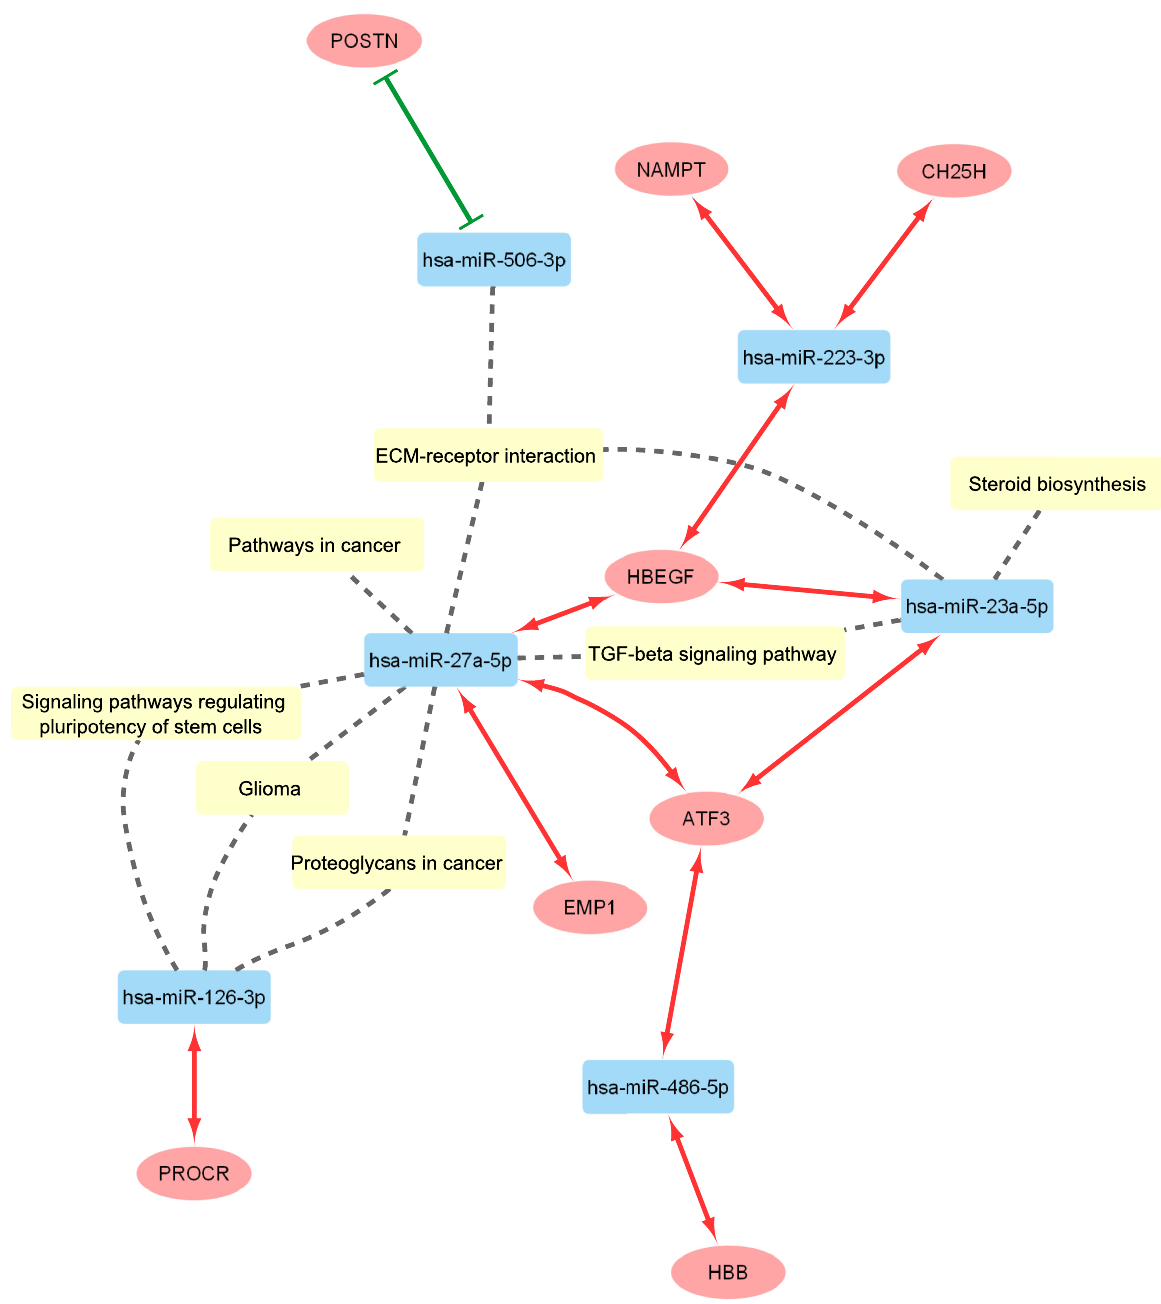
Fig 1. Network analysis of 12 miRNA-mRNA interaction pairs associated with OS in EOC patients. Each blue rectangular node represents a miRNA, whereas each red oval node presents a mRNA. Edge with solid green line indicates negative correlation between a miRNA and a mRNA (P < 0.05, R < -0.4), while red arrow line designates positive correlation (P < 0.05, R > 0.4). Dashed grey lines represent miRNAs being involved in various pathways as indicated by pathway enrichment